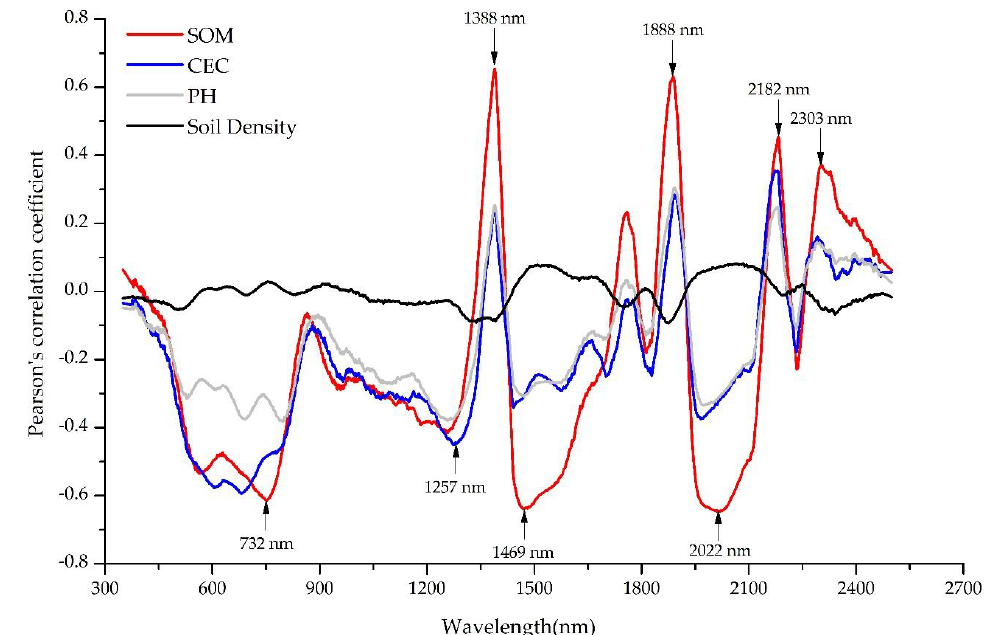
Figure 4. Pearson’s correlation coefficients between the soil-reflection spectral bands and soil (soil organic matter (SOM), cation exchange capacity (CEC), pH, and soil density), as functions of